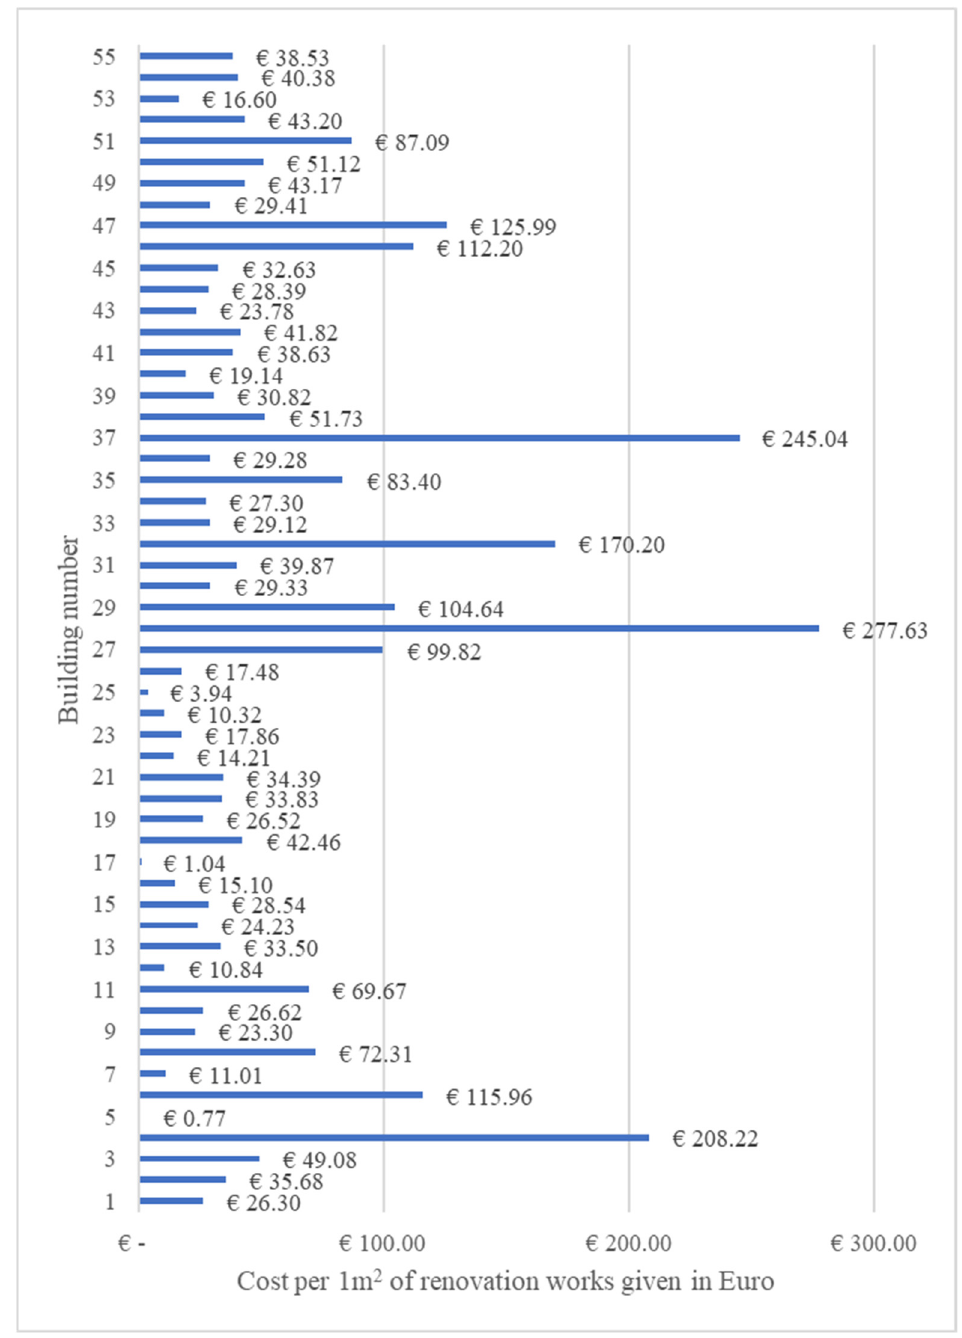
Figure 4. Renovation costs (in EUR) per 1 m 2 for the analyzed database and the analyzed period (2017–2021).